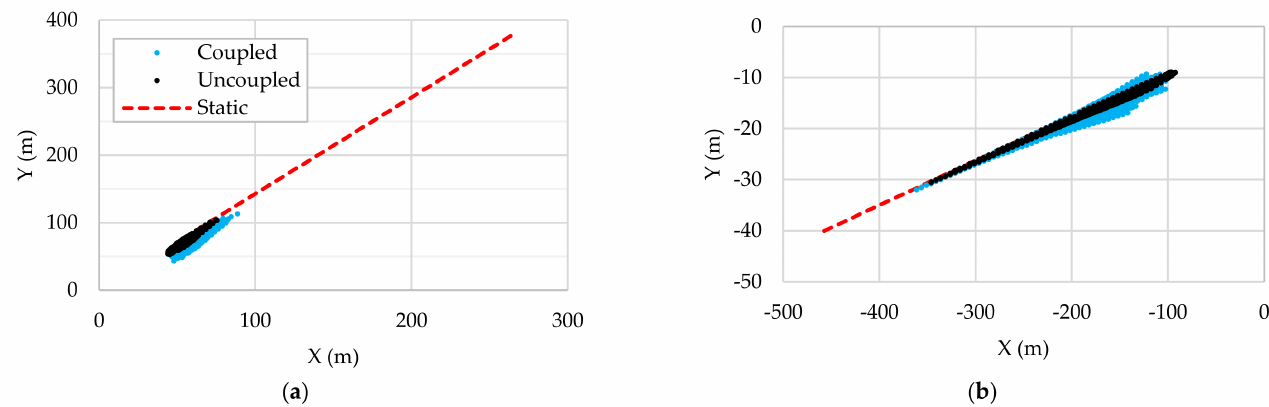
Figure 17. Anchor line TDP footprints for 50 y, heading 0 deg.: ( a ) ML2 slack line; ( b ) ML5 taut line. It is seen that the TDP footprints of the uncoupled case are distributed mostly along the static line direction, while the TDPs for the coupled case are broadly distributed, especially near the initial static TDP. These TDP variations for both the uncoupled and coupled cases are related to the mooring buoy motions depicted in Figure 10a. Due to the high tensions on the taut line of ML5, its TDP locations vary with much longer pattern toward the anchor point, compared to the slack line ML2. This results in a shorter seabed anchor line length on the taut lines (ML5, ML6), compared to the slack lines (ML1–ML4), as presented in Figure